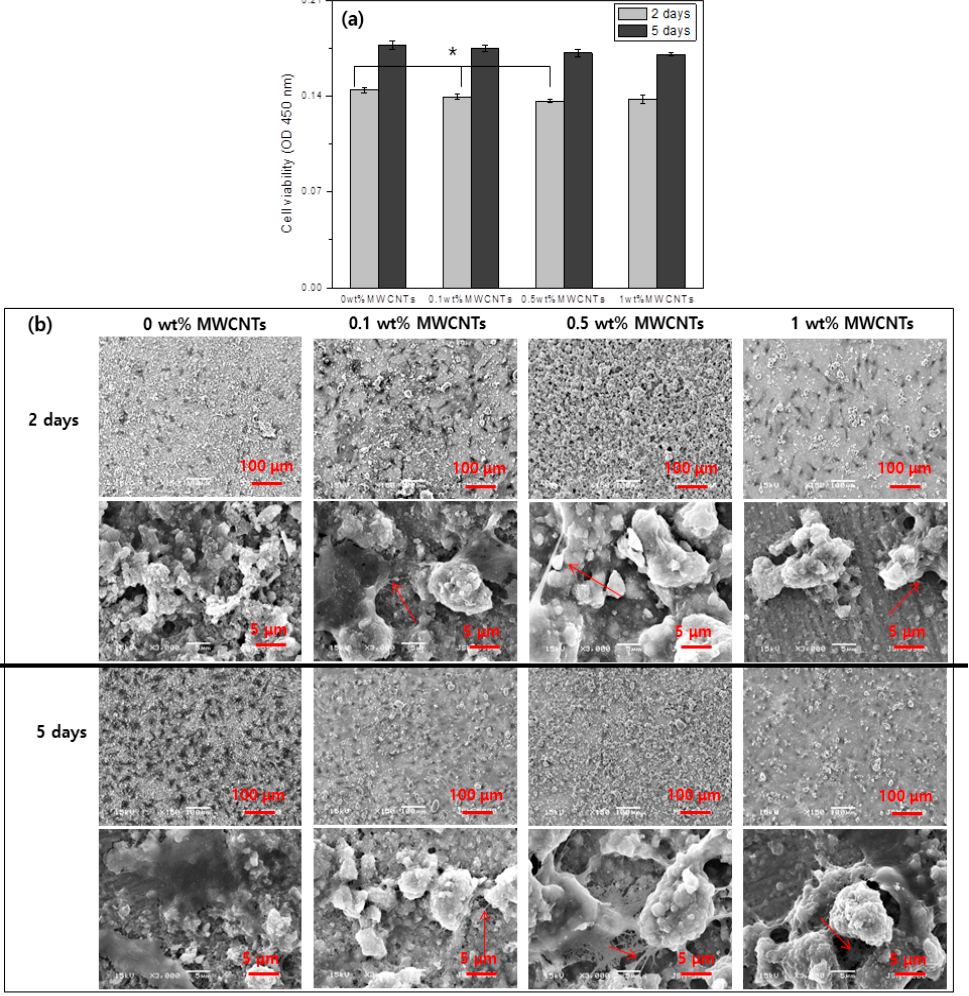
Figure 5. ( a ) The cell viability analysis by water soluble tetrazolium (WST). ( b ) The cytoskeleton analysis of the MC3T3-E1 cells for 2 and 5 days culturing on the MWCNTs-HA nanocomposite coating with various MWCNT contents (0, 0.1, 0.5 and 1 wt %) on titanium.